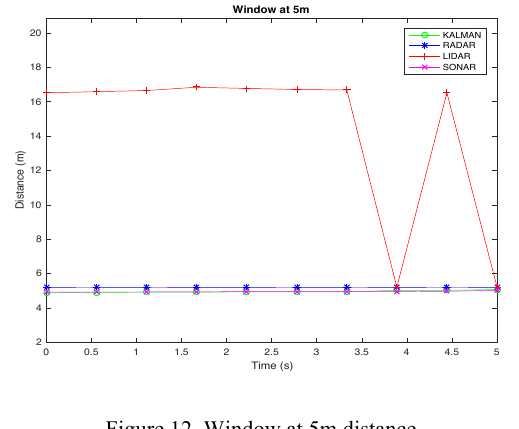
Figure 12. Window at 5m distance